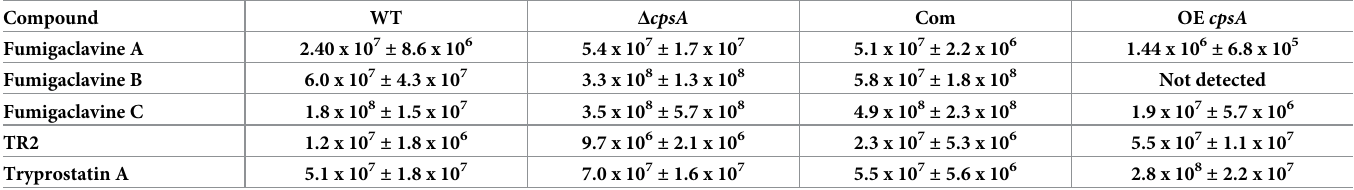
Table 4. LC-MS analysis data (average of normalized values ± standard